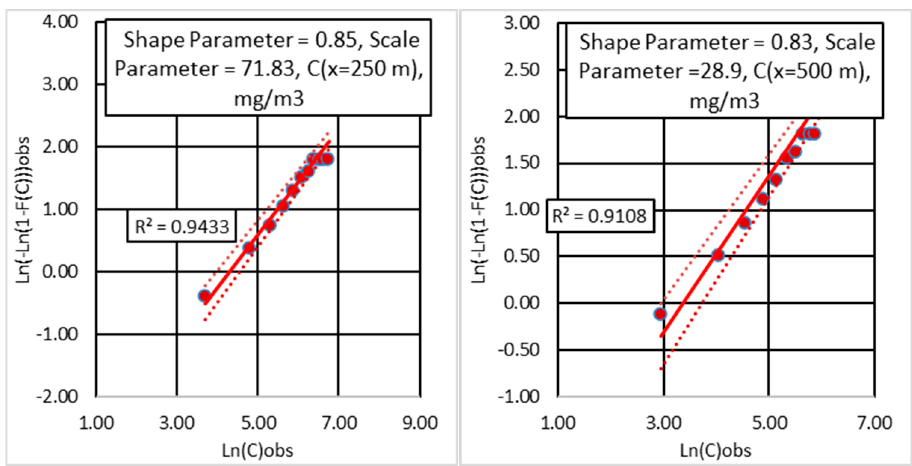
Figure 13. Monte Carlo air pollution generation for x = 500 m, (cid:1840)(cid:1841) (cid:1876) .